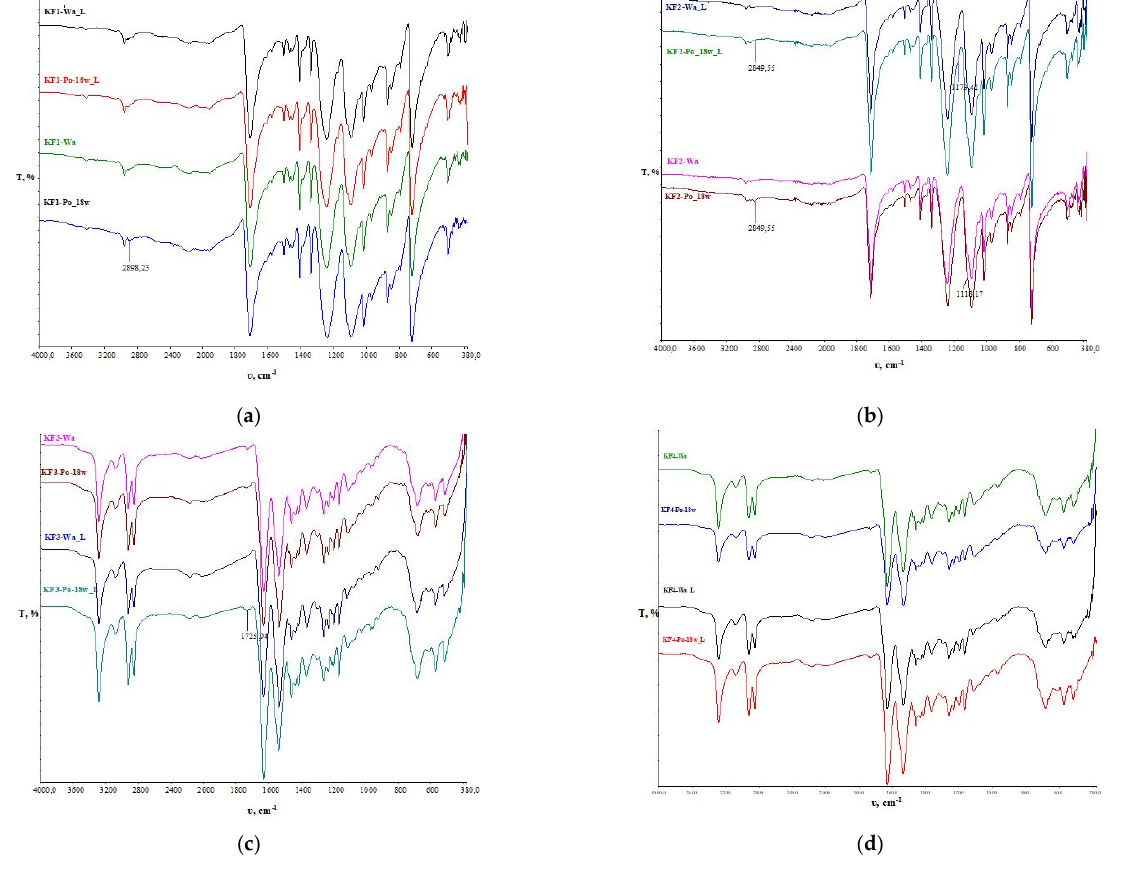
Figure 14. Fourier Transform Infrared (FT-IR) spectroscopy spectrum of the samples before aging (Wa) and after 3 weeks of outdoor aging (Po-18w) for the face (L) and back side of the material: ( a ) KF1; ( b ) KF2; ( c ) KF3; ( d ) KF4.